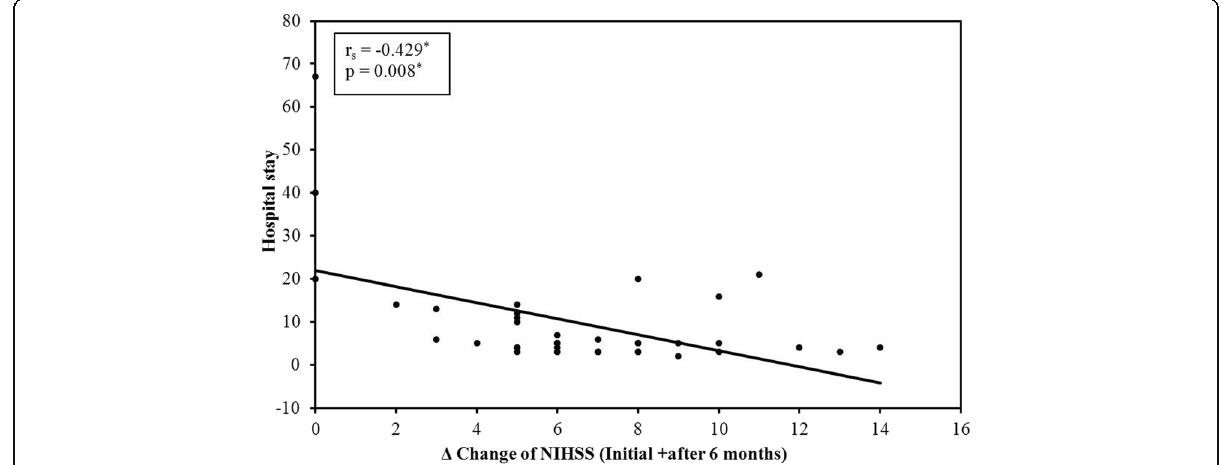
Fig. 3 Correlation between Δ change of NIHSS (initial-after 6 months) with hospital